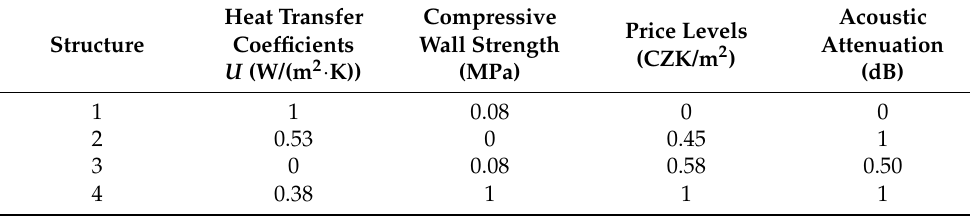
Table 5. Values after recalculating Table 3 by Section